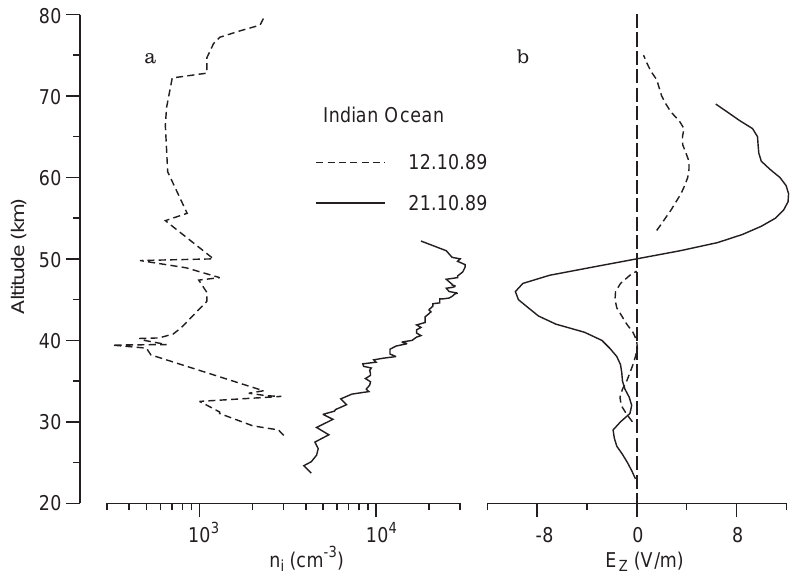
Fig. 4. The altitude profiles of a the positive ion density and b the vertical electric field strength measured in the Southern Hemisphere. The dashed curves show the measurements under relatively quiet geomagnetic conditions. The solid curves show the measurements during the strong solar proton events. The ion densities are not shown above about 52km for the rocket flight on October 21, 1989 during the SPE because the ion trap was